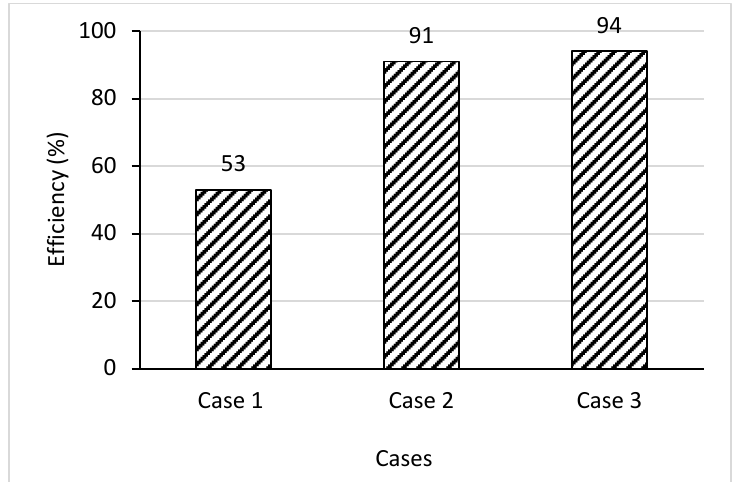
Table 4. Input values for case studies.